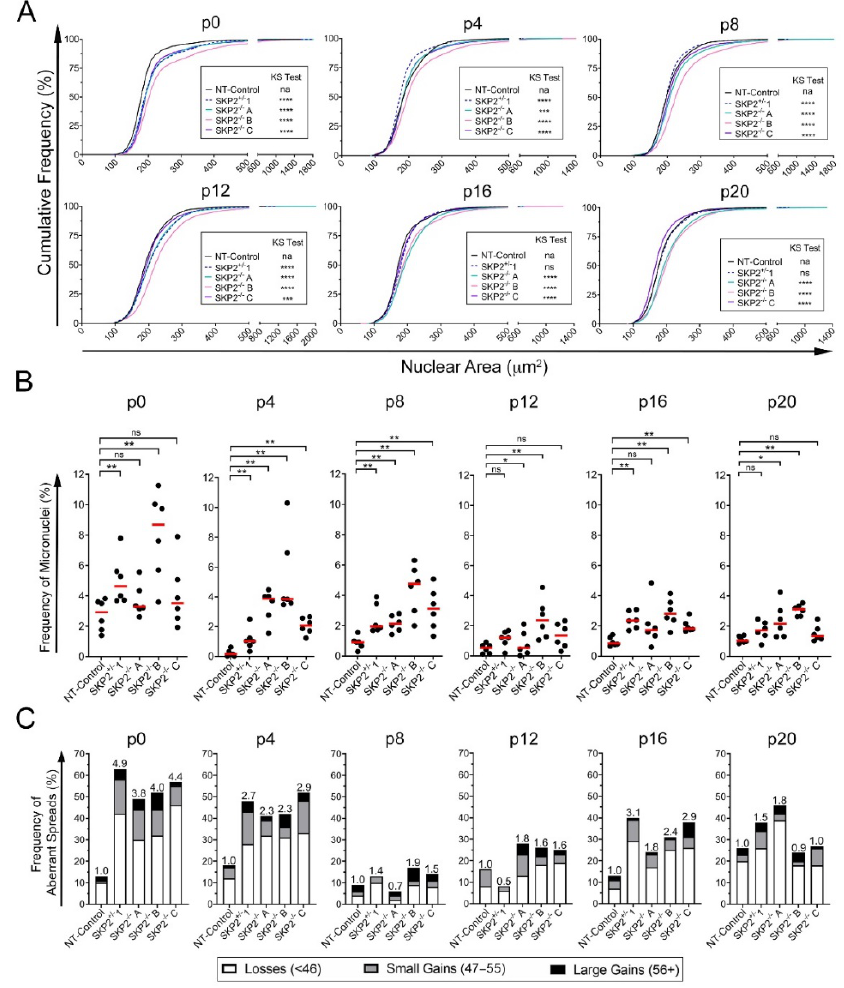
Figure 6. SKP2 Knockout Clones Display Dynamic Changes in CIN Phenotypes. ( A ) Cumulative distribution graphs reveal dynamic and significant changes in nuclear areas within SKP2 +/ − and SKP2 − / − clones over 10 weeks (p0 to p20) relative to NT-Control (two-sample KS test; na, not applicable; ***, p -value < 0.001; ****, p -value < 0.0001; N = 1; n = > 1000 nuclei/condition). ( B ) Dot plots uncover significant and dynamic increases in the frequency of micronuclei within SKP2 +/ − and SKP2 − / − clones from p0 to p20 relative to NT-Control (MW test; ns, not significant, p -value > 0.05; *, p -value ≤ 0.05; **, p -value < 0.01; N = 1; n = 6). ( C ) Bar graph depicting the frequencies of spreads with aberrant chromosome numbers, including chromosome losses, small-scale gains, and large-scale gains in SKP2 +/ − and SKP2 − / − clones over 10 weeks (p0 to p20) relative to NT-Control. The fold increase in total frequencies of aberrant spreads relative to NT-Control is presented above each bar (N = 1, n = 100 spreads/condition).